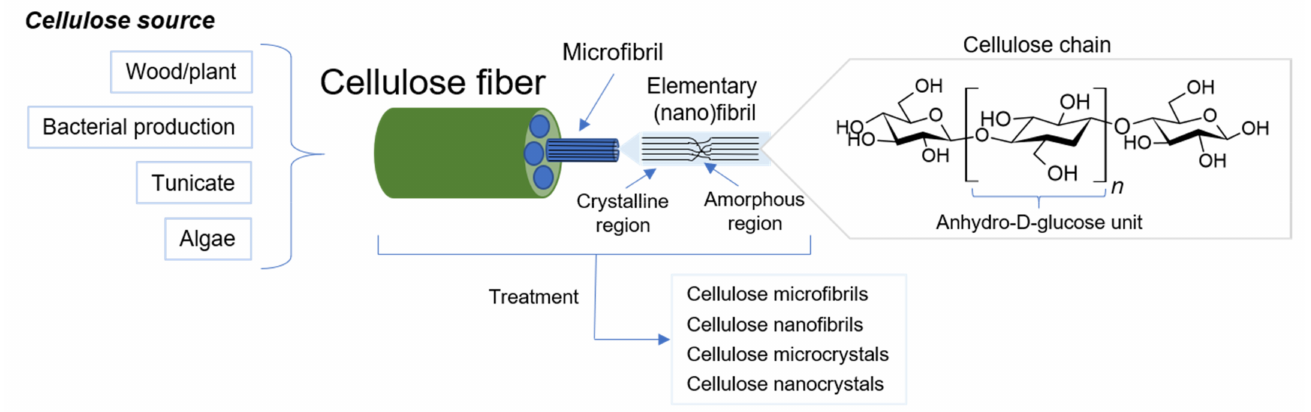
Figure 1. Cellulose from source to molecule and micro- and